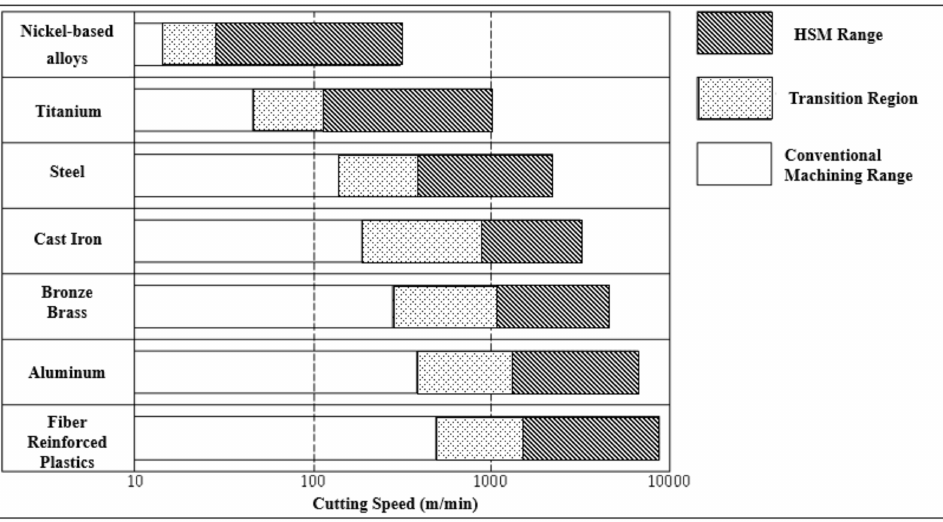
Figure 3. Ranges of cutting speeds for various materials (adopted from